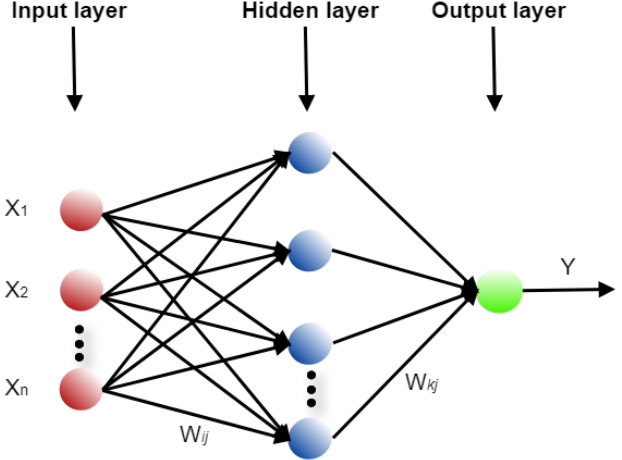
Figure 2. The general architecture of an artificial neural network of FITNET type.